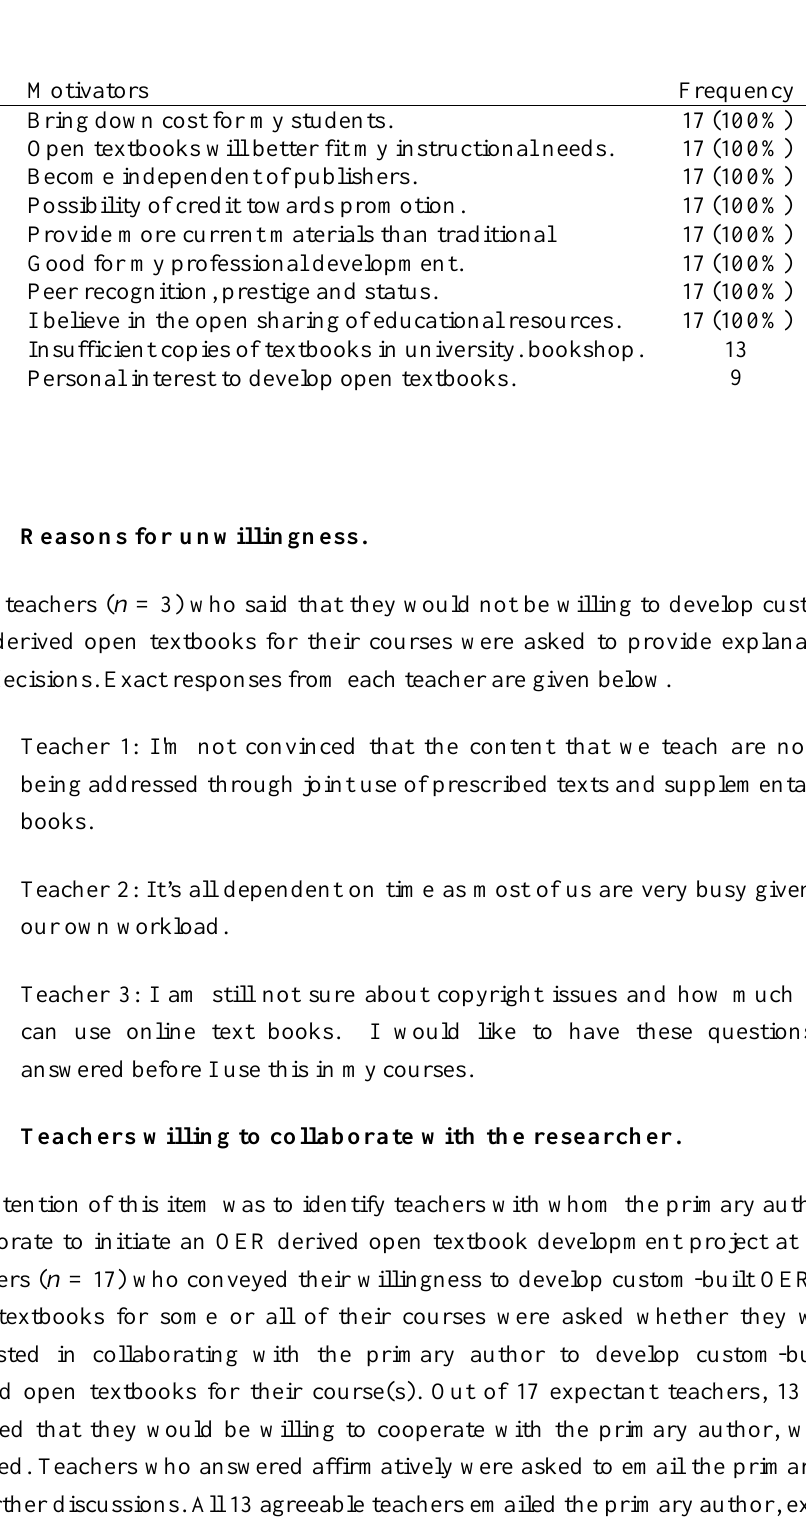
Table 10 Motivators to Develop OER Derived Custom-Built Open